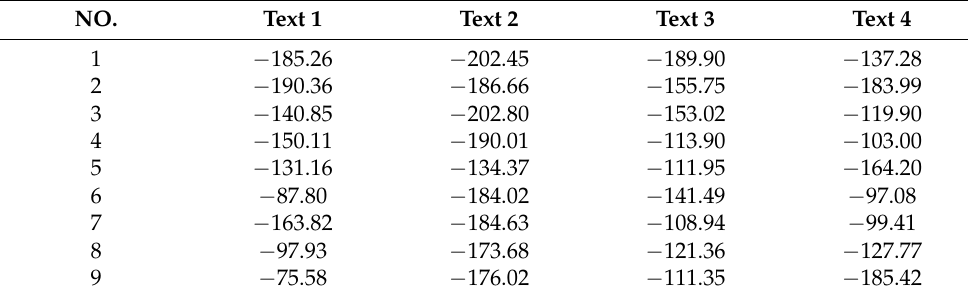
Table 5. Compression residual stress test